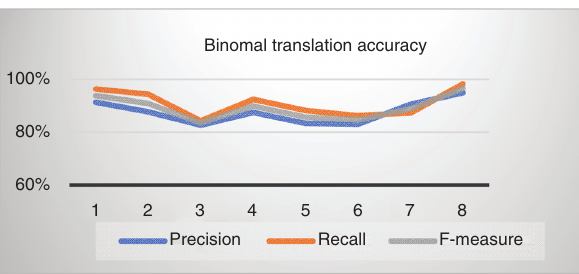
Figure 13: Binomial Classification Accuracy of